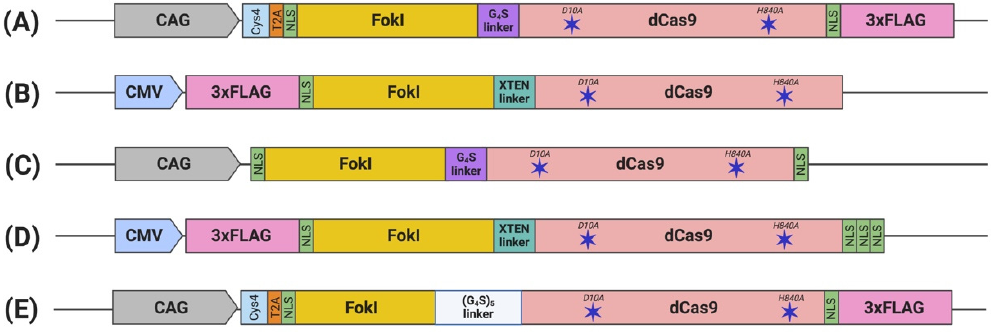
Figure 2. Schematic illustration of engineered FokI–dCas9 (fdCas9) constructs. Constructs are generated by ( A ) Tsai et al., ( B ) Guilinger et al., ( C ) Nakagawa et al., ( D ) Aouida et al., and ( E ) Havlicek et al. fdCas9 expression is driven by a strong constitutive human promoter (CMV and CAG). FokI endonuclease is fused to the N-terminal of the dead Cas9 (dCas9) [22 – 26].